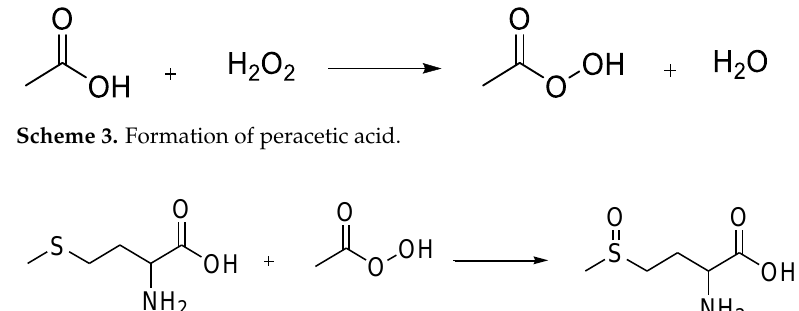
Figure 7. ( a ) Concentration in methionine sulfoxide vs storage time at room temperature for one-month aged bag irradi- ated at 59 kGy containing a solution of water (methionine = 50µM). ( b ) Plots of maximum of concentration in methionine sulfoxideF after 21 days of storage vs ageing of bag after irradiation at various doses. LOQ for limit of quantification and LOD for limit of detection. Reproduced from [42] with the permission of Polymers.